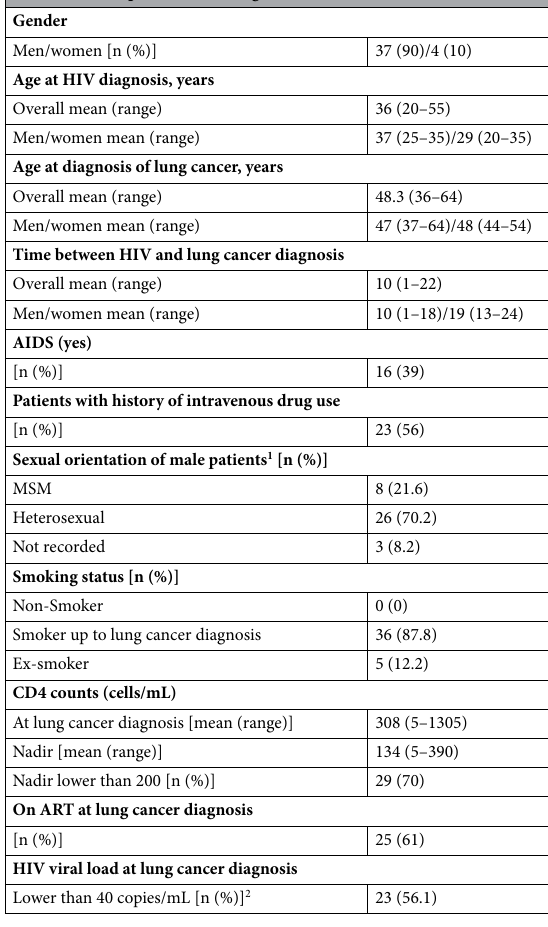
Table 1. Demographic and clinical characteristics of HIV-1-infected patients with lung cancer. MSM men who have sex with men, ART antiretroviral therapy. 1 The four women were heterosexual. 2 Two patients on ART with detectable HIV viral load had a viral load of 27,168 and 540,000